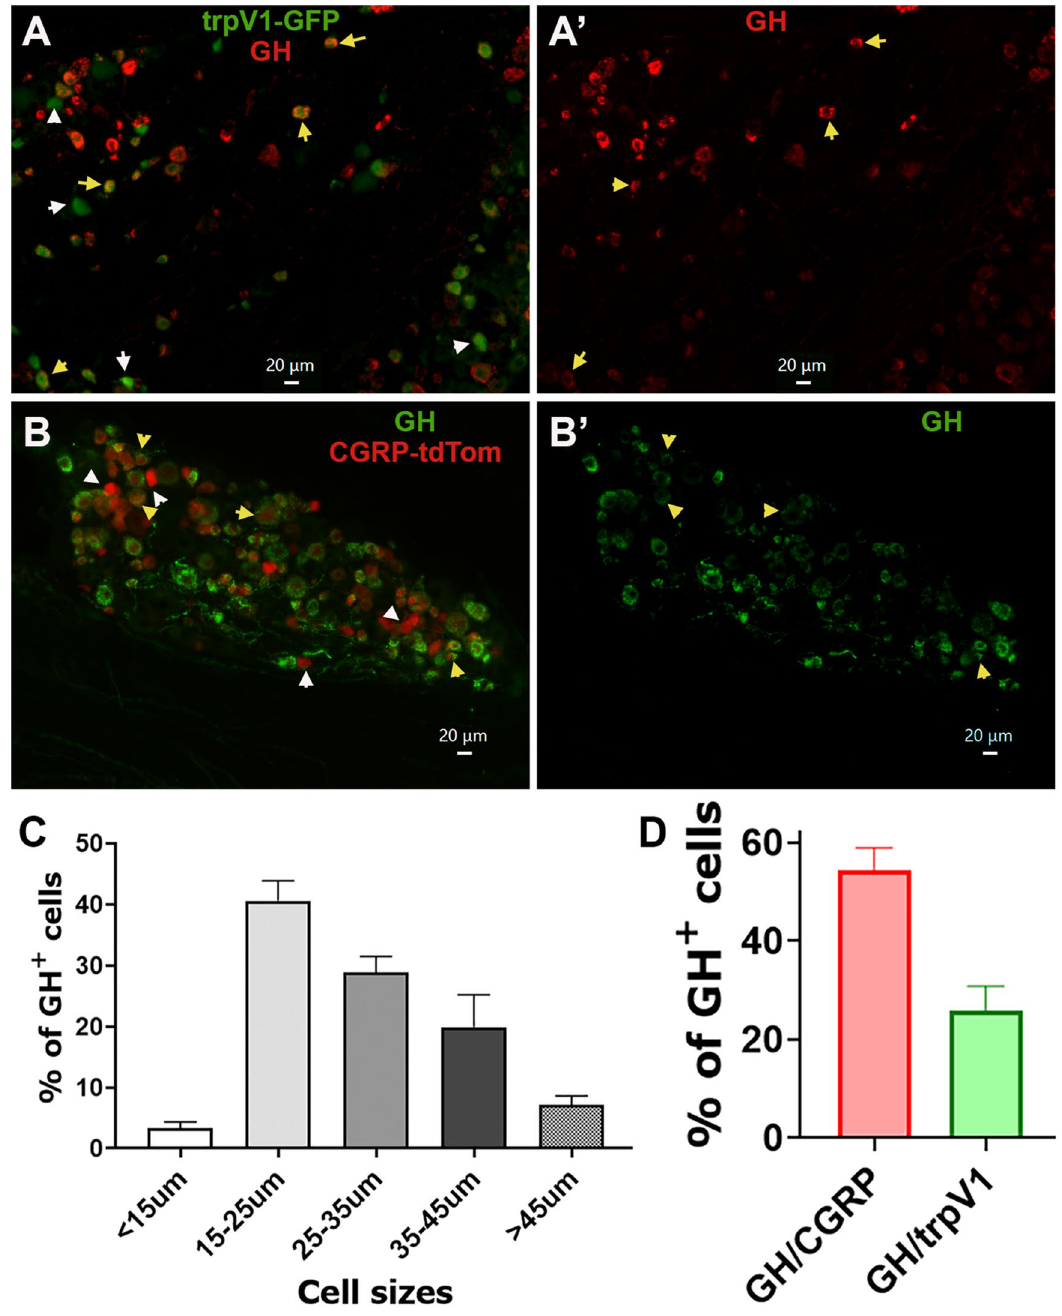
Figure 5. Size distribution of GH + cells in TG and co-expressions of GH with CGRP/TdTomato + and TrpV1- GFP + TG neurons. ( A and A’ ) Immunohistochemistry (IHC) of TG section from TrpV1-GFP reporter mouse with GH (red). Yellow arrows show TrpV1 + /GH + cells and white arrows TrpV1 + /GH - cells. White bars correspond to 20 μm on images captured with 20 × objective. ( B and B’ ) IHC of TG section from CGRP cre-ER / TdTomato reporter mouse with GH (green). Yellow arrows show CGRP + /GH + cells and white arrows CGRP + / GH - cells. White bars correspond to 20 μm on images captured with 20 × objective. ( C ) Cell size distribution of GH + cells in TG of three independent mice. ( D) Percentages of GH + cells co-expressing with CGRP cre-ER / TdTomato and trpV1-GFP-positice TG sensory